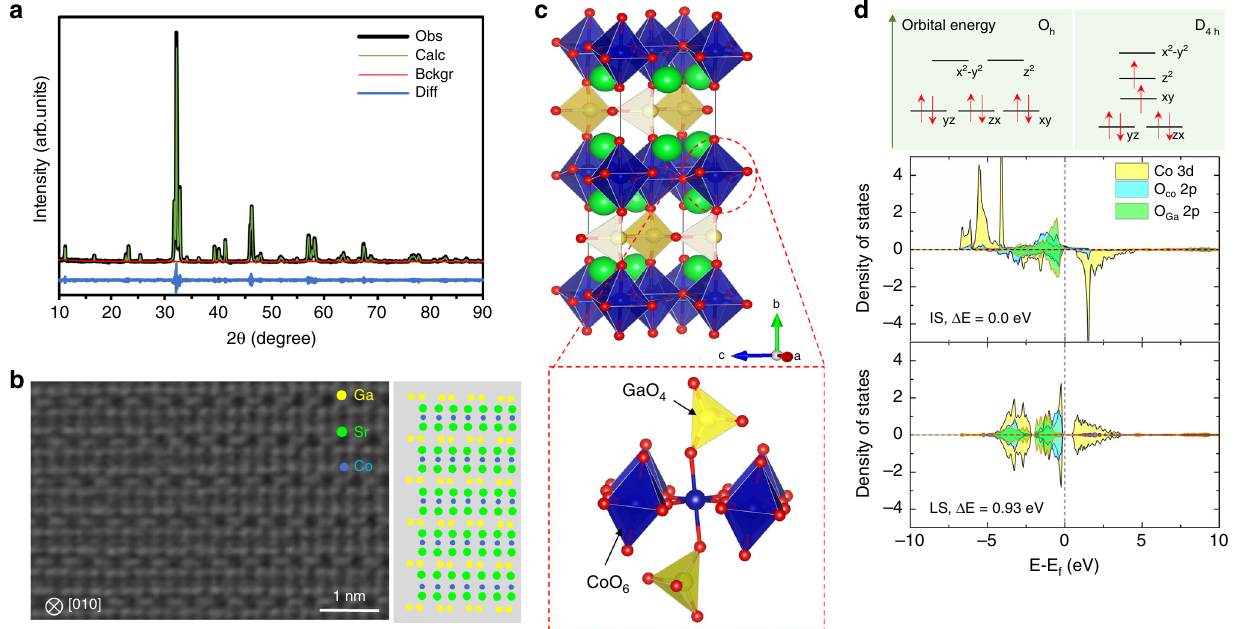
Fig. 1 Crystalline and electronic structure of Sr 2 GaCoO 5 . a X-ray diffraction pattern and the Rietveld re fi nement results. The discrepancy factors are R p = 7.3% and R wp = 9.73%. b HAADF - STEM image of Sr 2 GaCoO 5 . The right-side model illustrates the observed ordering of cations that matches the Brownmillerite structure. c Graphic depiction of the crystal structure and bonding environment around the cobalt cation. Cobalt, gallium, strontium, and oxygen are colored as blue, yellow, green and red, respectively. d Splitting of Co 3 + d-orbitals in O h and D 4h crystal fi eld and the calculated density of states projected on Co d states, p states of oxygen that bridges two CoO 6 (O Co ) and that bridges CoO 6 and GaO 4 (O Ga ). The intermediate spin con fi guration is 0.93 eV per formula unit more stable than the low spin con fi guration